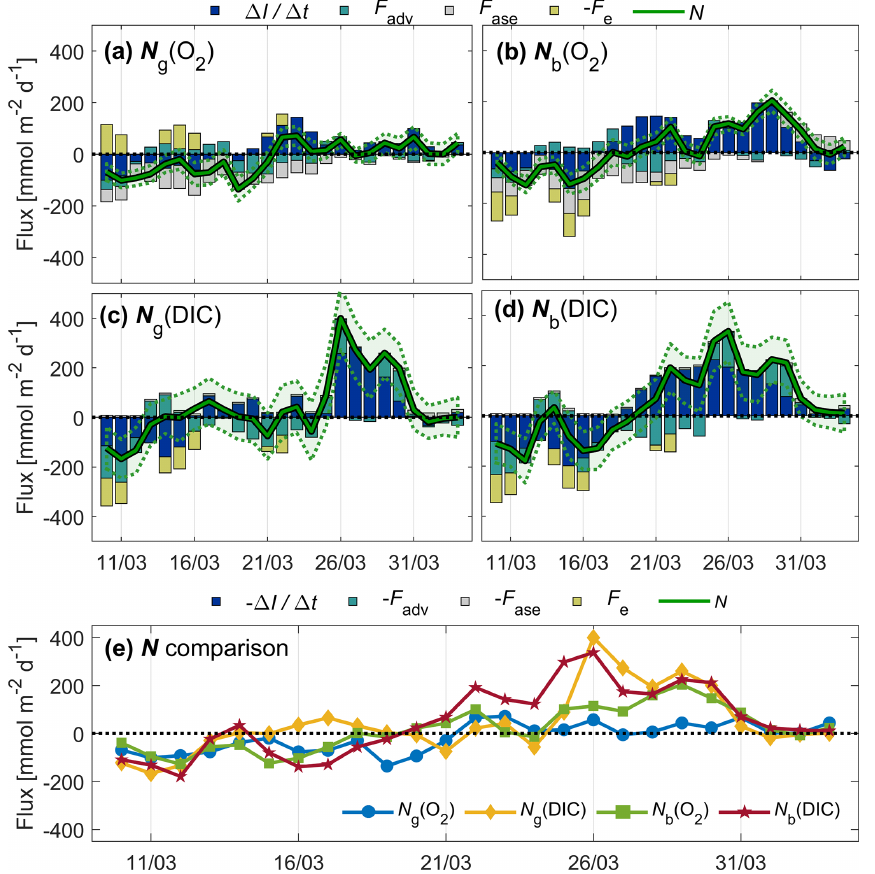
Figure 9. Inventory change ( (cid:49)I/(cid:49)t ), advection ( F adv ), air–sea exchange ( F ase ), entrainment ( F e ) fluxes, and net community production ( N ) of O 2 ( a, b ; top legend) and DIC ( c, d ; bottom legend) related to glider (a, c) and buoy (b, d) measurements. Uncertainty intervals are shown as dotted lines. All N estimates are compared in panel (e)